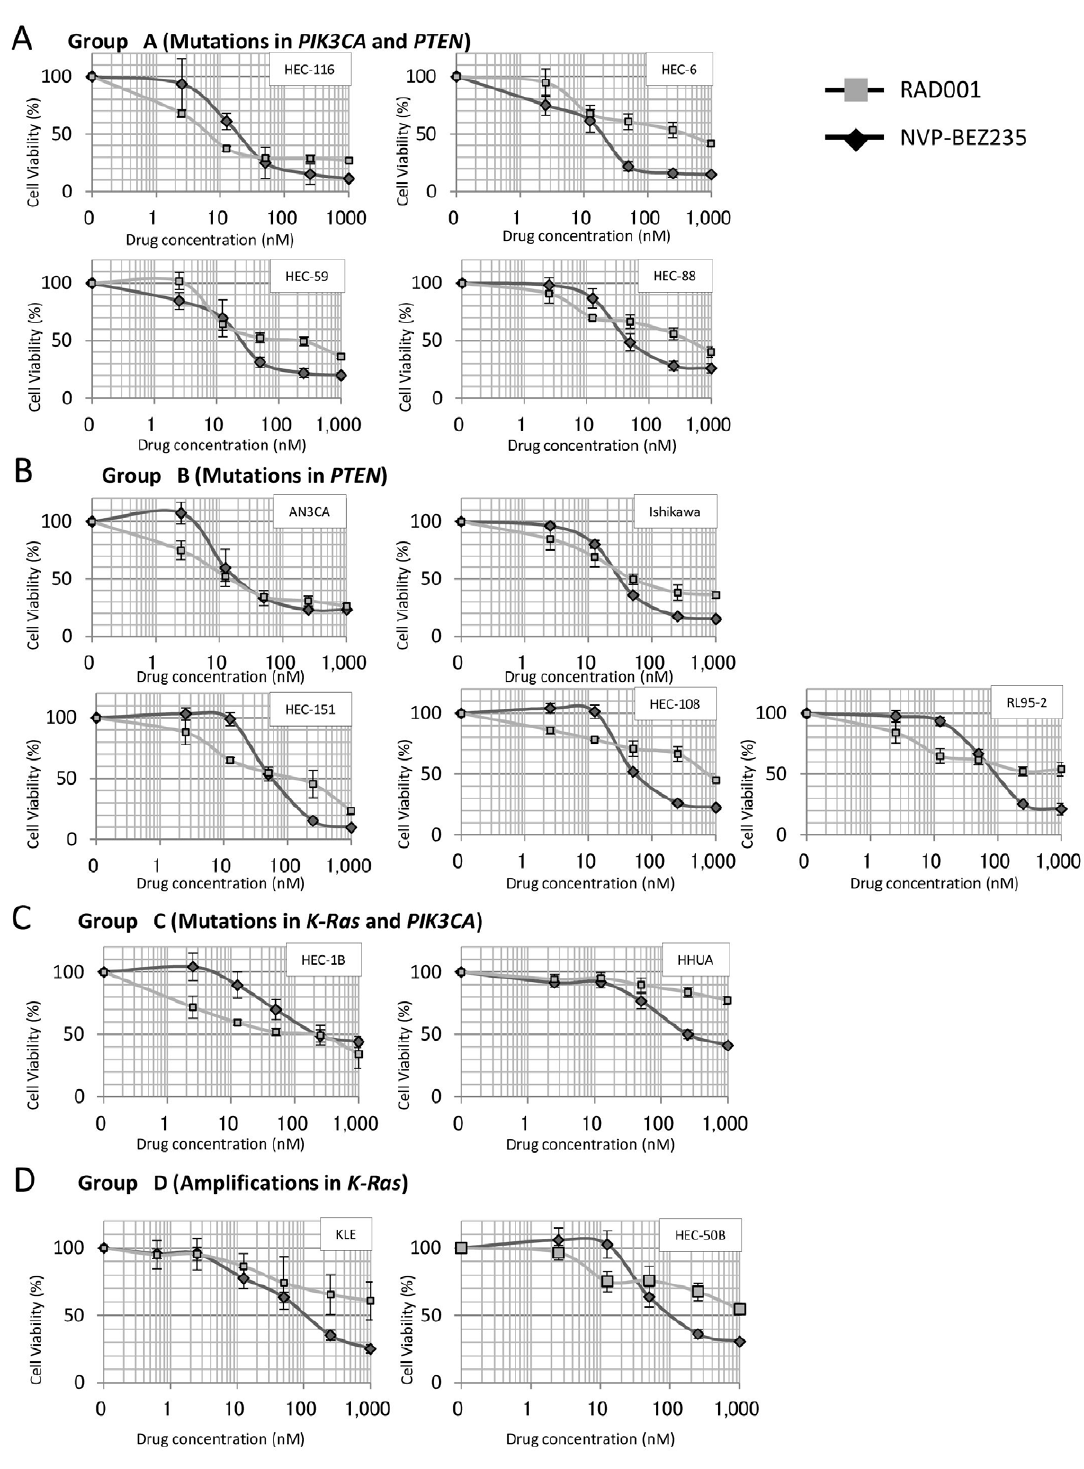
Figure 2. Inhibition of cell proliferation by NVP-BEZ235 and RAD001. (A)–(D) WST-8 assay showing the sensitivity of endometrial cancer cells to NVP-BEZ235 and RAD001 at increasing concentrations of drug (nmol/L) for 72 h. The data was normalized to the value of control cells. (A) Four group A cell lines with double mutations of PIK3CA and PTEN , (B) Five group B cell lines with PTEN mutations, (C) Two group C cell lines with coexistent mutations of K-Ras and PIK3CA , and (D) Two group D cell lines with chromosomal copy number amplification at the locus of K-Ras . All experiments were repeated 3 times, and each value is shown as the mean of 3 experiments 6 S.D.